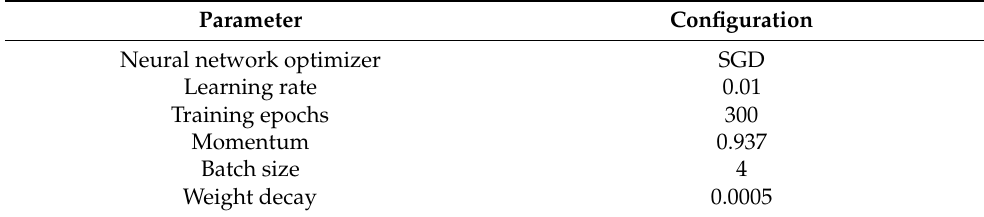
Table 3. BC-YOLO experimental training parameters.